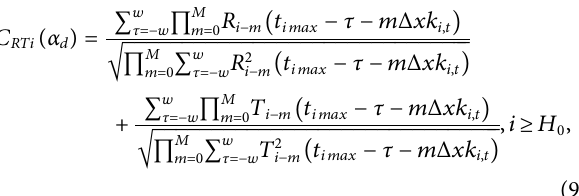
Frontiers in Earth Science |